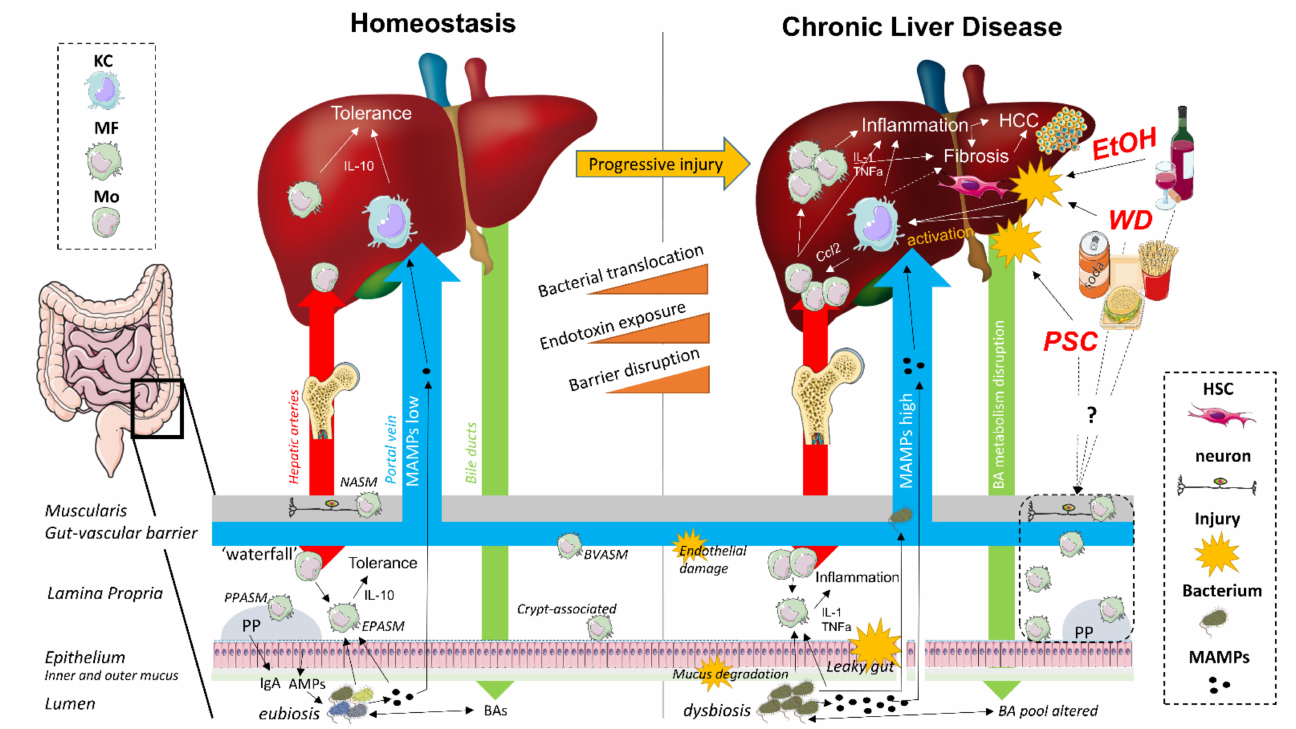
Figure 1. Gut–liver axis in homeostasis and chronic liver disease. Left: In homeostasis, gut microbiota are in a eubiotic state, balanced by IgA and anti-microbial peptides (AMP), and are pivotal in maintaining bile acid (BA) homeostasis. Epithelial-associated macrophage (MF) subsets in the lamina propria are continuously replenished by bone marrow-derived monocytes, which are rendered tolerogenic by eubiosis and physiological levels of microbe-associated molecular patterns (MAMP). The intestinal MF pool further consists of subsets that occupy specific niches. Under homeostatic conditions, the MF pool in the liver mainly consists of Kupffer cells (KC), while small numbers of monocyte-derived MFs (MoMF) and bone marrow-derived monocytes (Mo) are also present. Normal gut–liver axis-associated physiology maintains hepatic immunological tolerance. Right: Progressive injury from different etiologies including alcohol abuse (EtOH), Western diet (WD) consumption and cholestasis (PSC) is associated with dysbiosis, BA pool alterations and intestinal barrier disruption, leading to bacterial translocation and endotoxin exposure. How the intestinal MF pool is altered during CLD progression requires further attention. In the injured liver, Mos and MoMFs infiltrate and induce a shift in the composition of the MF pool. Hepatic MFs are instrumental in CLD-associated inflammation, progressive fibrosis and HCC development. AMPs: anti-microbial peptides; BAs: bile acids; BVASM: blood vessel-associated macrophage; EPASM: epi-thelium-associated macrophage; EtOH: ethanol; HCC: hepatocellular carcinoma; KC: Kupffer cell; MF: macrophage; Mo: monocyte; NASM: neuron-associated macrophage; PP: Peyer’s patch; PPASM: Peyer’s patch-associated macrophage; PSC: primary sclerosing cholangitis; WD: Western